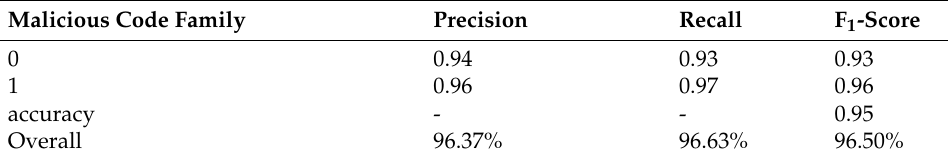
Table 5. Parameter setting of model.